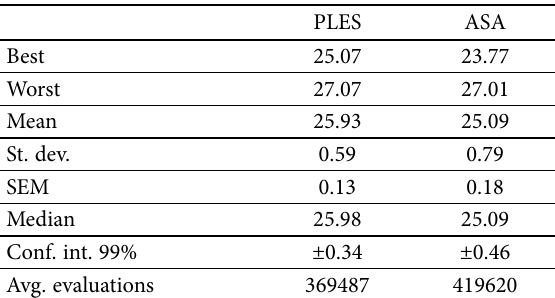
Table 20. Pairwise comparisons with the Wilcoxon test